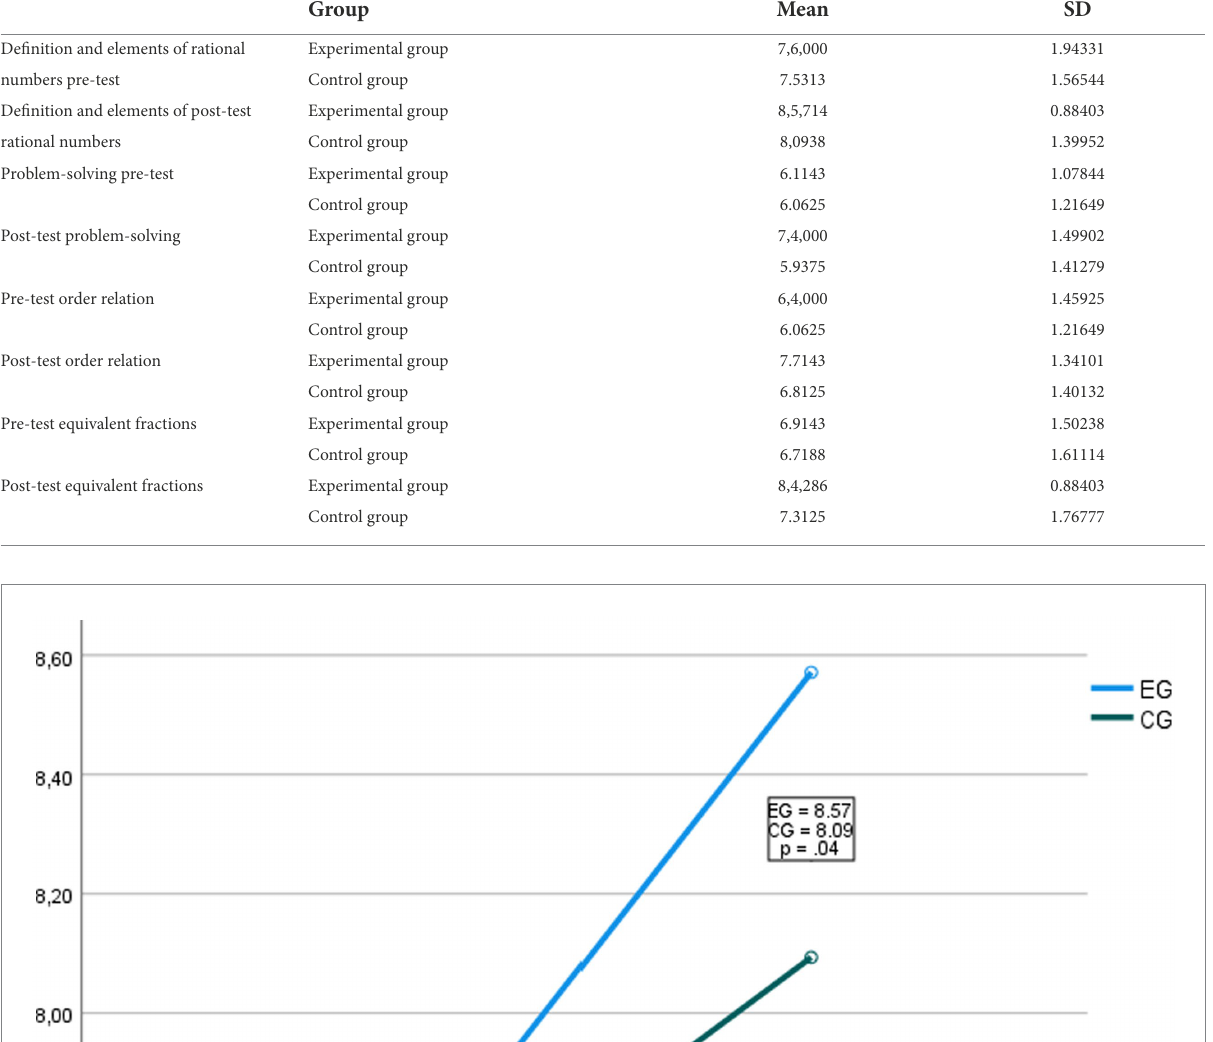
FIGURE 2 Comparison of the control and experimental groups in definition and